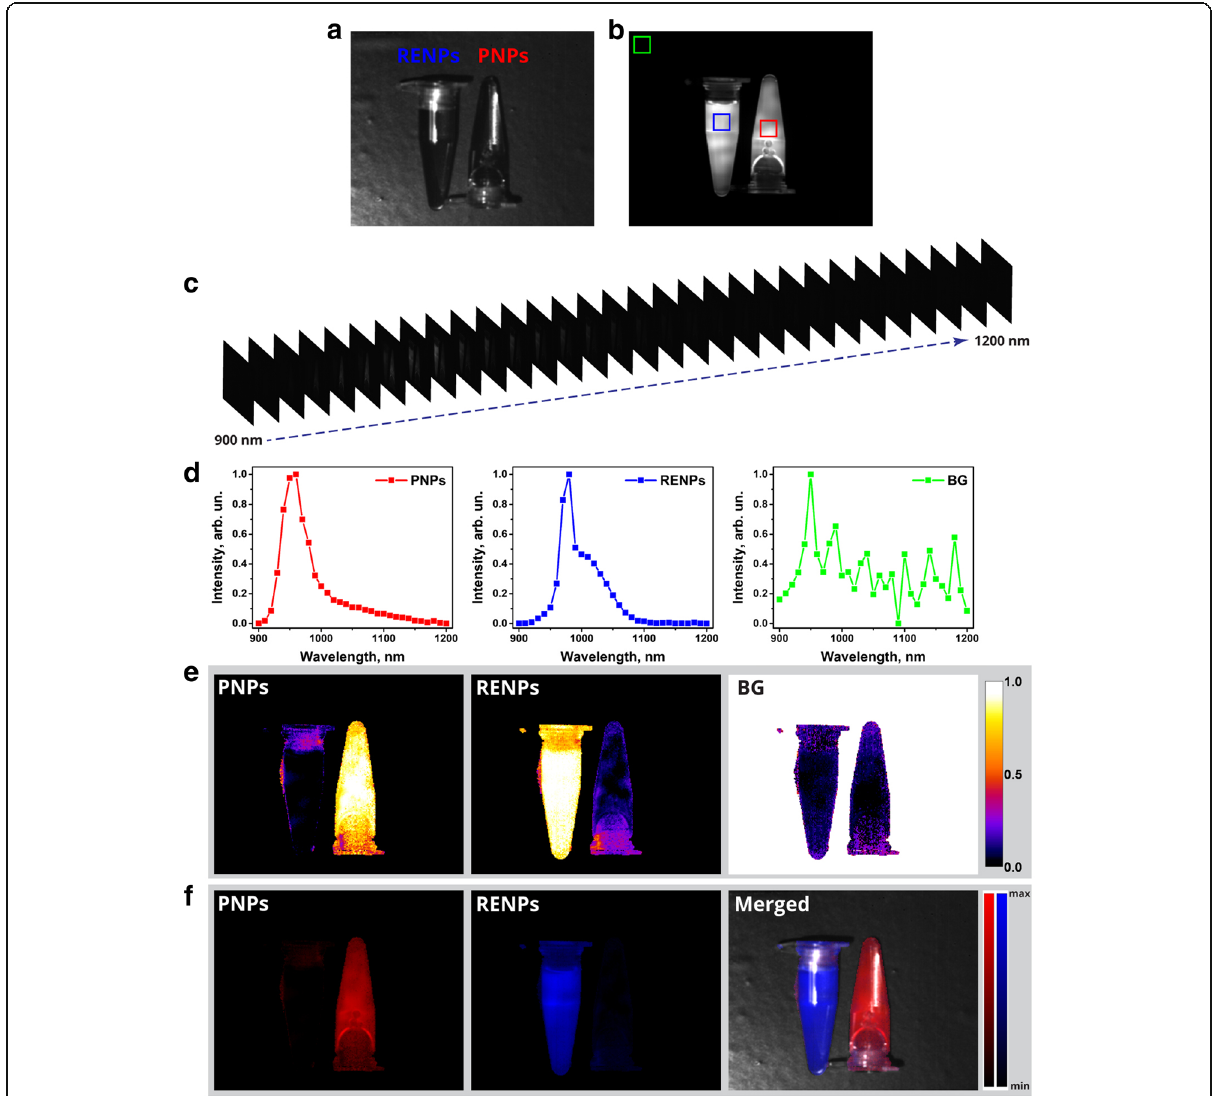
Fig. 4 HSI of microcentrifuge tubes containing RENPs and PNPs. a Bright field image of microcentrifuge tubes with PNPs and RENPs suspended in PBS. b PL image of PNPs and RENPs samples excited with 808 nm (850-nm-long pass filter was used for image acquisition). c Scheme illustrating hypercube composed of HSI frames. d Spectral profiles of PNPs, RENPs, and background (BG) averaged from ROI shown in b as red, blue, and green squares, correspondingly. e Color maps of components abundances. f Reconstructed intensity images of the PL components and PL/bright field merged